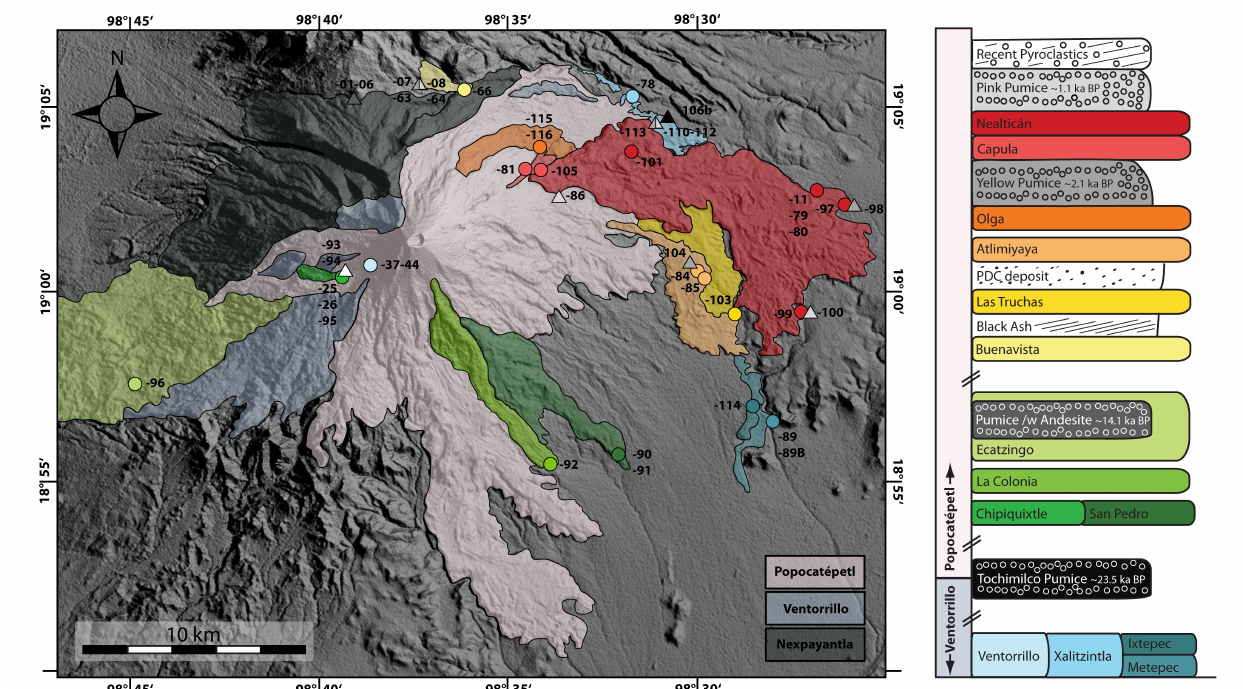
Figure 2: Geological map of the Popocatépetl Volcanic Complex (PVC) and stratigraphy of the current edifice. For clarity, only e ff usive units are shown. Previous edifices are outlined in muted colours, lavas of the last ∼ 23.5 ka are coloured blue to red according to their relative ages. Sample locations are indicated as circles (lavas) and triangles (pumices). Sample numbers are given without the prefix (POP) for the sake of